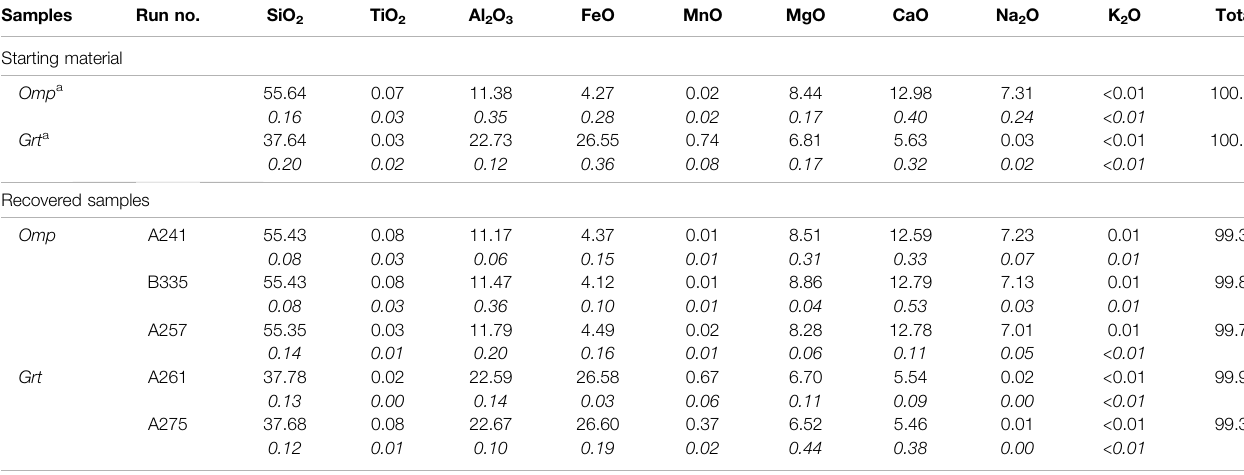
TABLE 1 | Composition of omphacite and garnet in eclogite (wt%). Samples Run no. Starting material